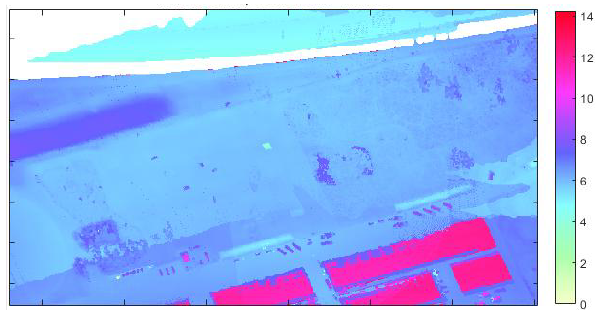
Figure 9: The same terrain with vegetation being removed. The height is color-coded.